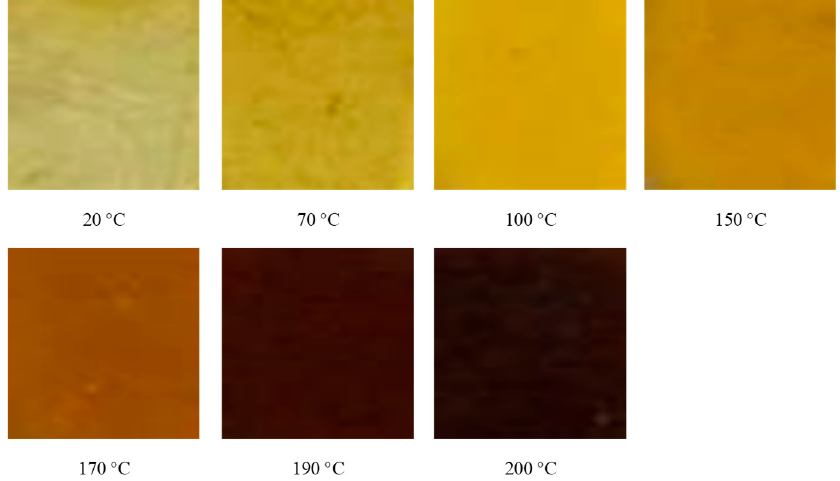
Figure 6. The morphology of HTPB film at different temperatures.